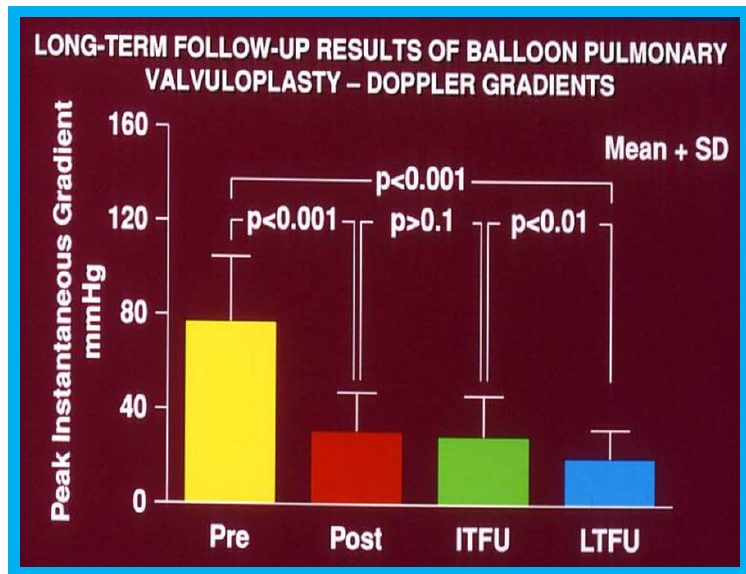
Figure 13. Graph showing calculated Doppler peak instantaneous gradients prior to (Pre) and one day after (Post) balloon pulmonary valvuloplasty (BPV) and at intermediate-term (ITFU) and long-term (LTFU) follow-up: Significant decrease ( p < 0.001) following BPV (Pre vs. Post) occurred which did not change ( p > 0.1) at ITFU. But, at LTFU, there was a further decrease ( p < 0.001) in the Doppler-calculated gradients. Mean + standard deviation (SD) are depicted. Reproduced from Rao P.S., et al. [16].